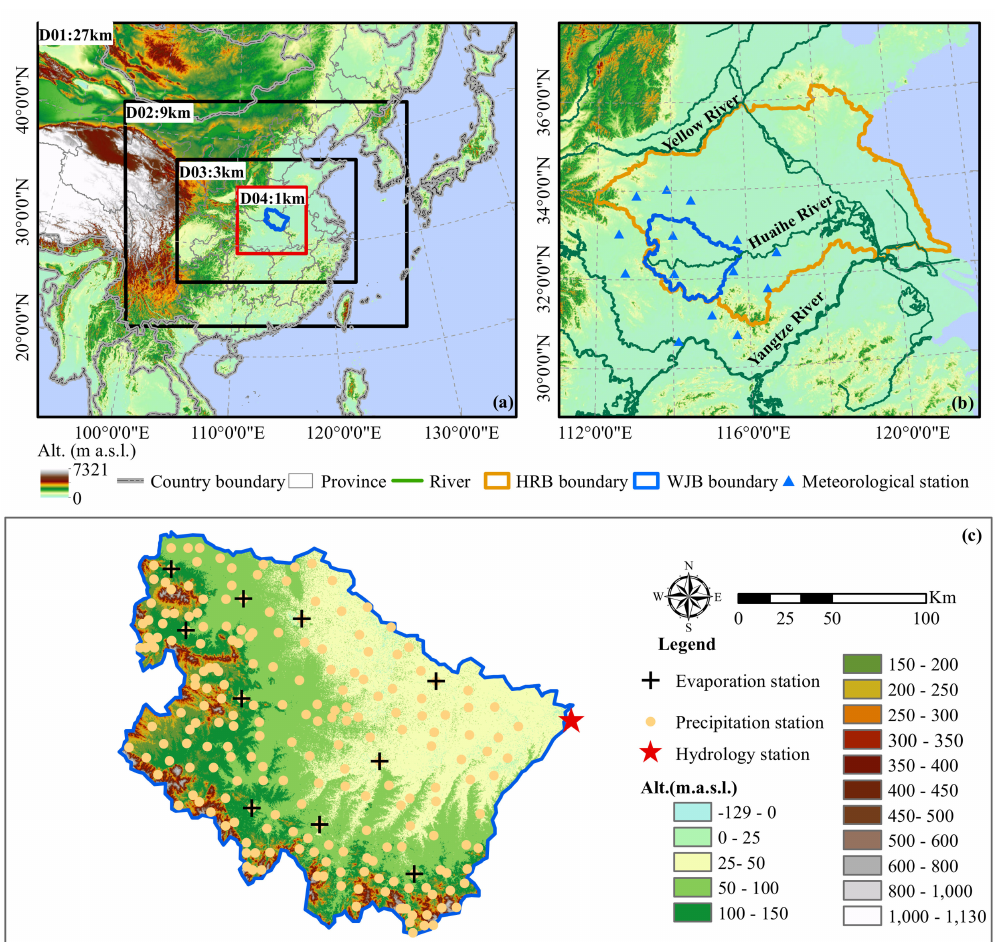
Figure 1. ( a ) The first, second, third and fourth domain sets in the WRF model: D01: 27-km resolution; D02: 9-km resolution; D03: 3-km resolution; D04: 1-km resolution; ( b ) locations of the Huaihe River basin (HRB), the Wangjiaba (WJB) watershed and its 14 meteorological stations; ( c ) altitude (Alt.) of the WJB watershed and its inner 215 precipitation stations, 10 evaporation stations and the hydrology